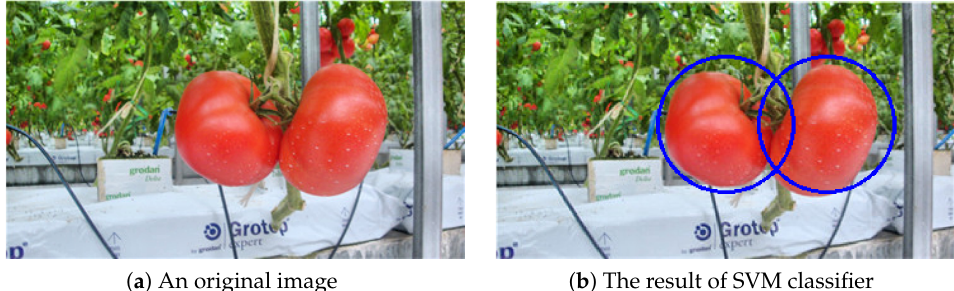
Figure 11. An example of SVM classification: ( a ) before and ( b ) after applying the SVM